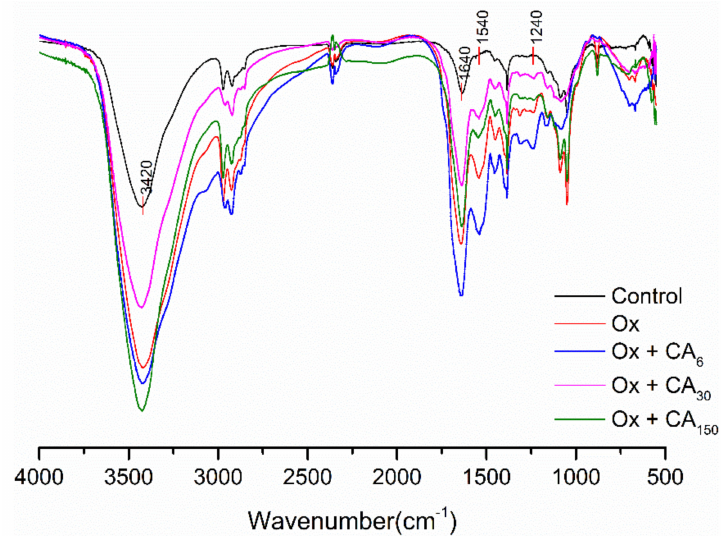
Figure 2. FT-IR spectra of oxidized myofibrillar protein (MP) treated with di ff erent concentrations of chlorogenic acid (CA). Control: nonoxidized; Ox: oxidized; Ox + CA 6 , Ox + CA 30 , and Ox + CA 150 : oxidized in the presence of CA at 6, 30, and 150 µ M / g protein,